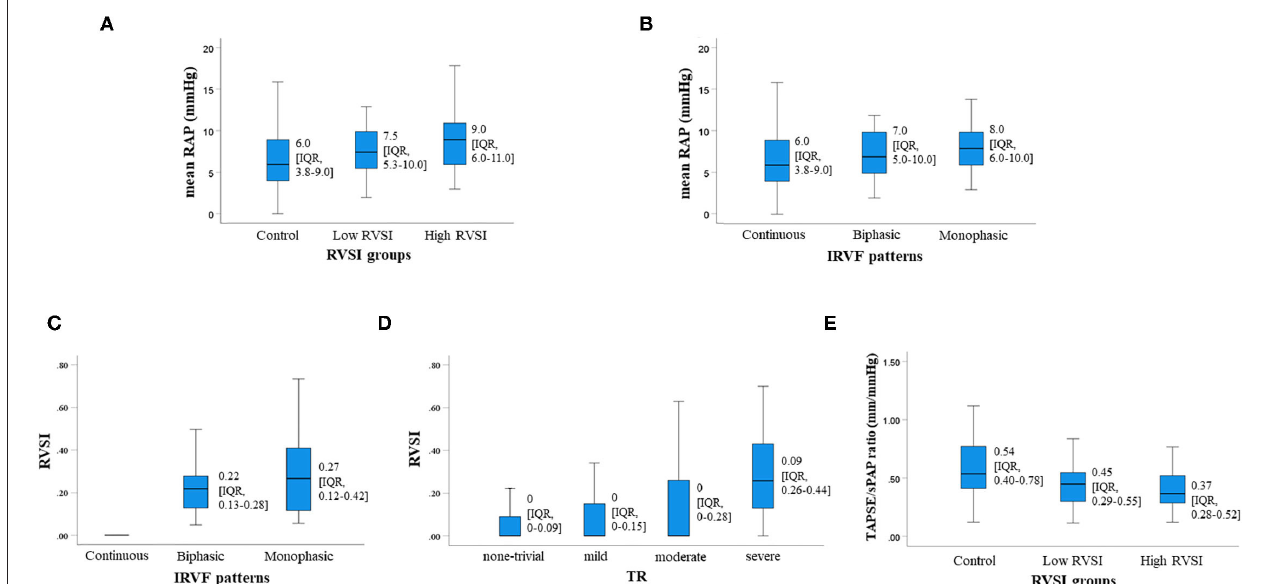
FIGURE 2 | The severity of renal congestion can be assessed by measuring RVSI using renal Doppler ultrasonography. (A,C–E) show the relationship between RVSI and mRAP (A) IRVF patterns (C) severity of TR (D) and TAPSE/sPAP ratio (E) . RVSI showed a significant stepwise increase along the IRVF patterns ( C ; P < 0.001) and severity of tricuspid regurgitation ( D ; P < 0.001). TAPSE/sPAP ratio showed a significant stepwise decrease along the RVSI groups ( E ; P < 0.001). In addition, both RVSI and IRVF patterns showed similar associations with elevated mRAP ( A ; P < 0.001 and B ; P = 0.001). RVSI, renal venous stasis index; mRAP, mean right atrial pressure; IRVF, intrarenal venous flow; TR, tricuspid regurgitation; TAPSE/sPAP, tricuspid annular plane systolic excursion/systolic pulmonary artery pressure; IQR, interquartile